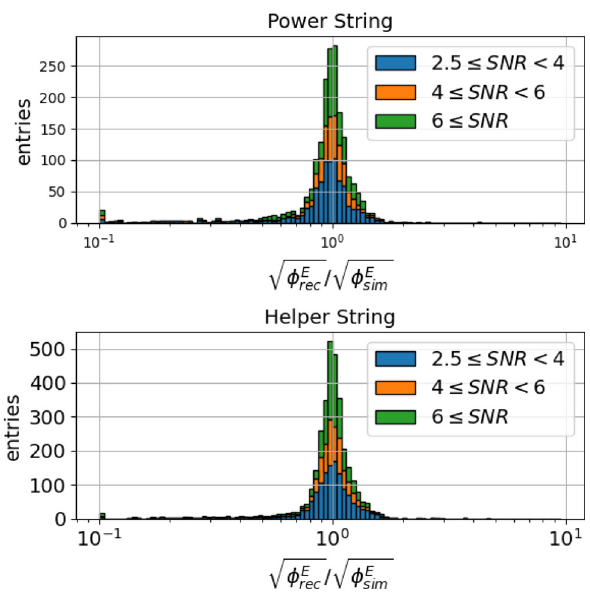
Fig. 12 Ratio between the square root of the energy fluence of the reconstructed and the actual radio signal detected at the power string (top) and the two helper strings (bottom). Results are divided into cat- egories by the maximum signal-to-noise ratio of the channels used for the reconstruction. The outermost bins are overflow